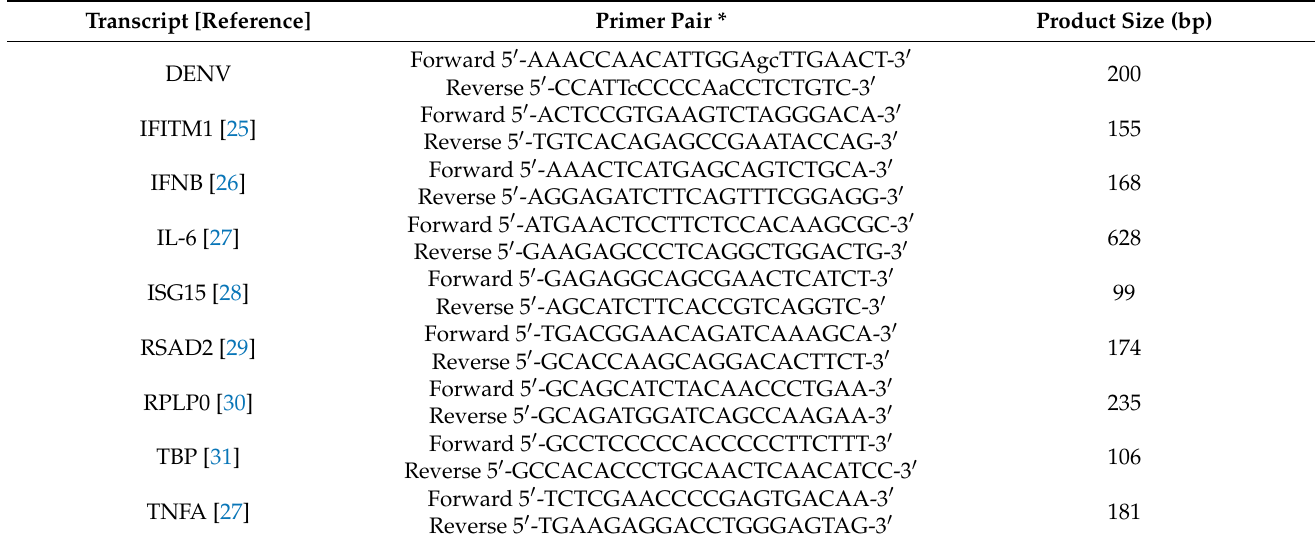
Table 2. Primer pairs and product sizes for gene